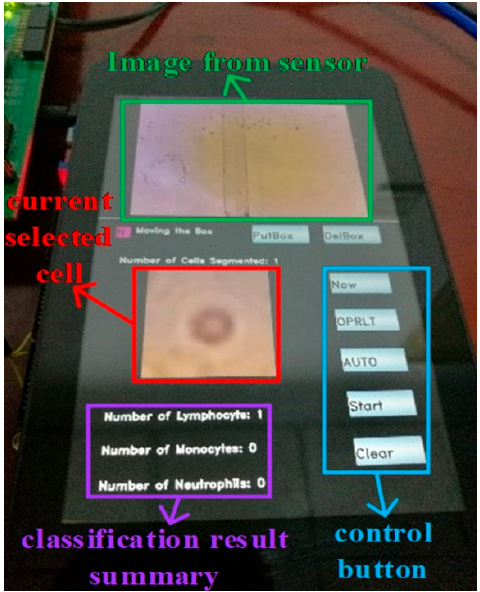
Figure 15. Touch panel display illustration.